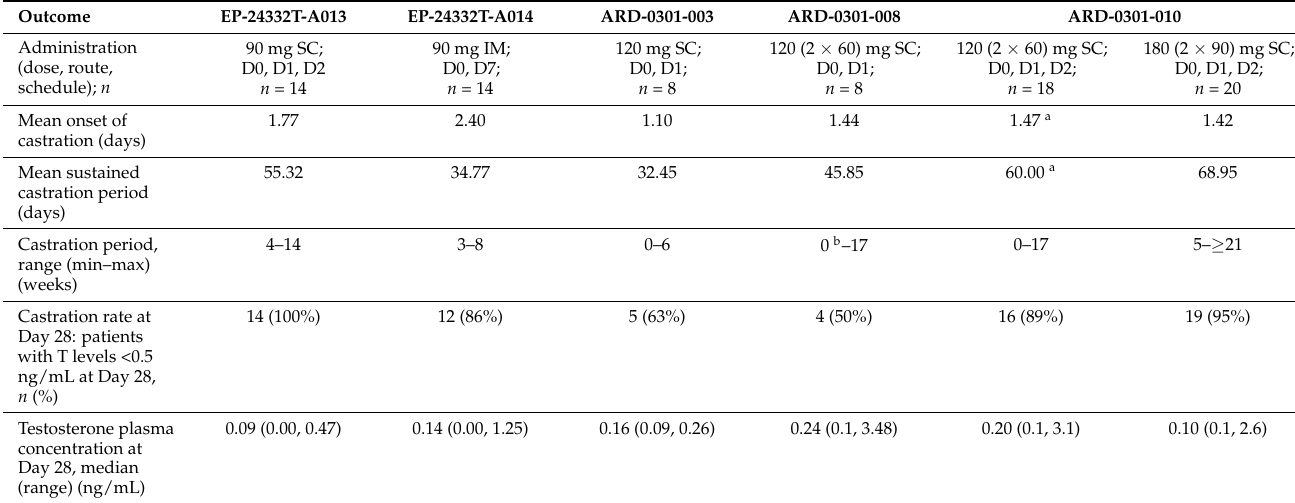
Table 2. Mean onset and duration of